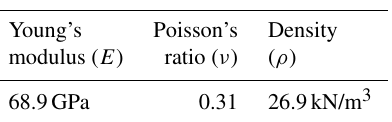
Table 1. Mechanical properties of the rock mass based on Urgonian limestone.